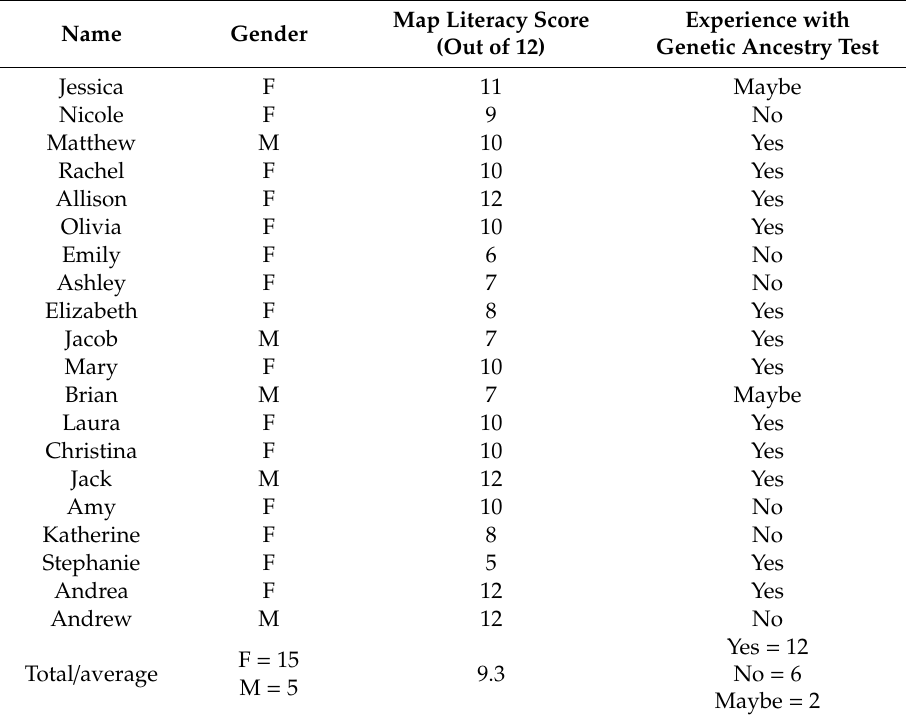
Table 1. Participant pseudonyms, genders, and questionnaire